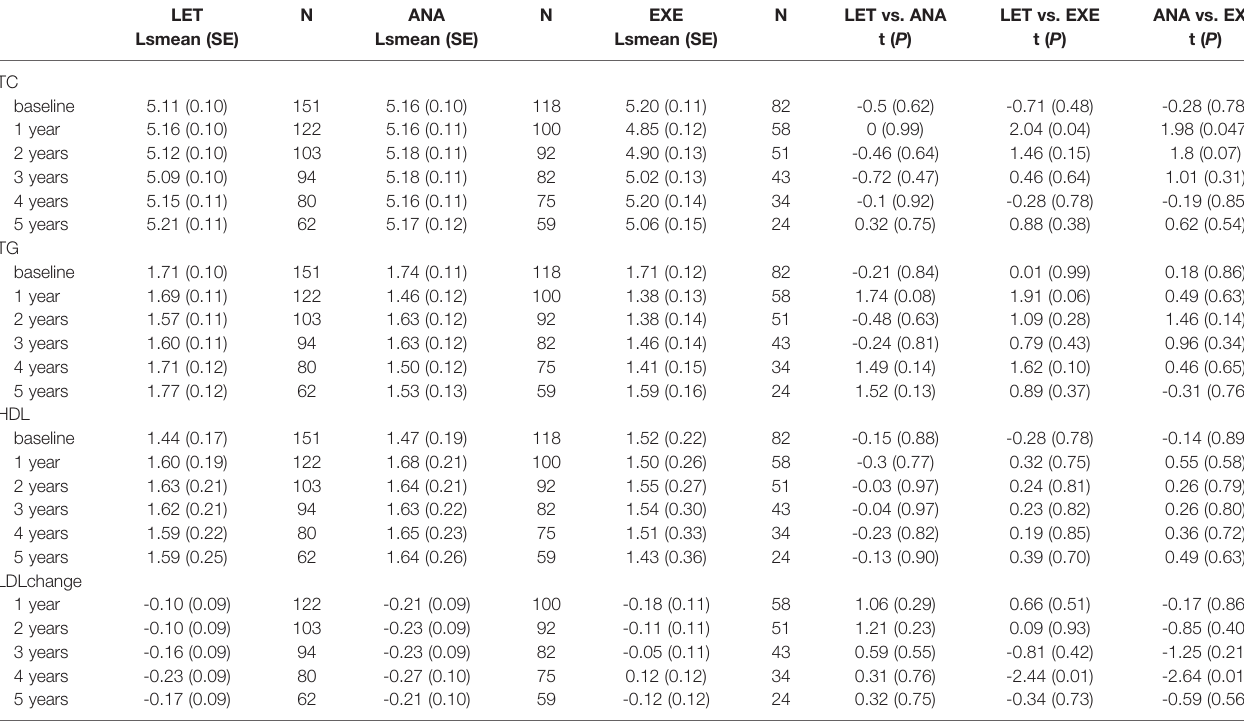
TABLE 5 | Comparision of lipid pro fi les among LET, ANA and EXE in postmenopausal BC patients. LET N ANA N EXE N LET vs. ANA LET vs. EXE ANA vs. EXE Lsmean (SE) TC